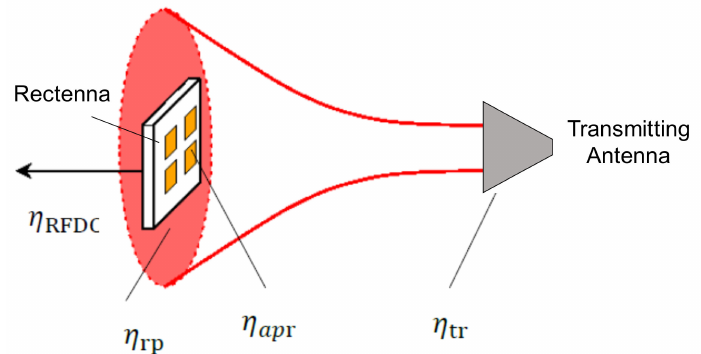
Figure 5. Conceptual diagram of power transmission efficiency in wireless power